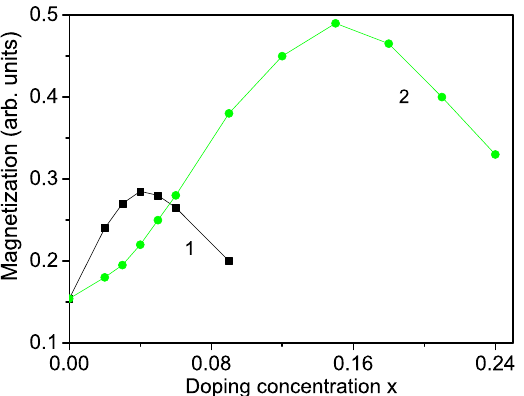
Figure 2. Doping concentration dependence of the spontaneous magnetization M s of a ZnS NP for N = 10 shells, T = 300 K for different doping ions: (1) Co; (2)